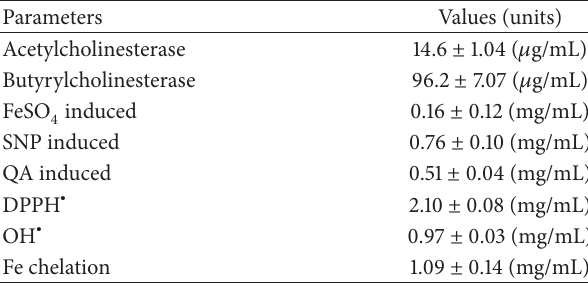
values for the acetylcholinesterase and butyryl- Table 1: IC 50 cholinesterase inhibitory activities; inhibition of FeSO quinolinicacidinducedMDAproductioninratsbrainhomogenates in vitro ; OH ∙ and DPPH ∙ scavenging ability as well as Fe 2+ chelating